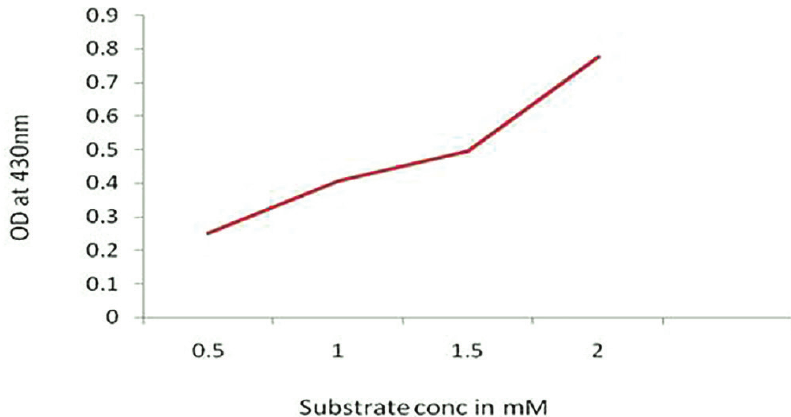
FIGURE 3 - Flasks showing cell filtrate with varying substrate concentration with control (A), 0.5 mM AgNO 1.5 mM AgNO (D) and 2 mM AgNO 3